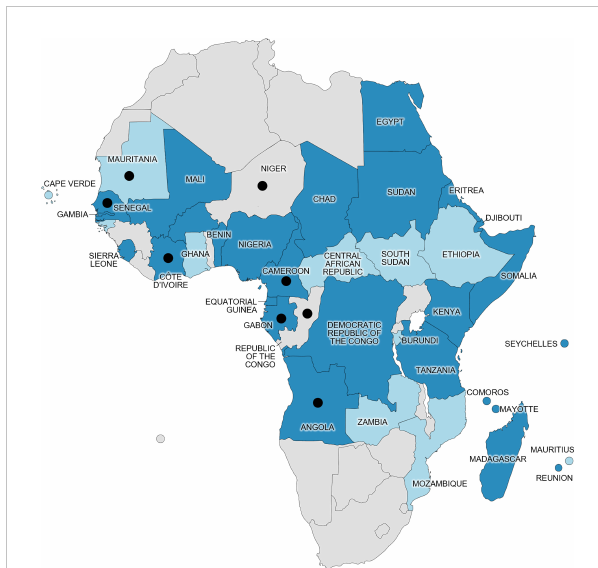
FIGURE 3 Distribution of con fi rmed human DENV cases in Africa prior to our study (at least one PCR-diagnosed case acquired in the country mentioned in a published report, as of December 2022) and location of DENV-1 cases in our study (black dots). Dark blue represents DENV-1 presence speci fi cally, and light blue represents DENV presence in general (other serotype or unserotyped). Gray represents absence of reported con fi rmed DENV human cases, as de fi ned by the World Health Organization (27). White represents bodies of water. Map generated using mapchart.net ©